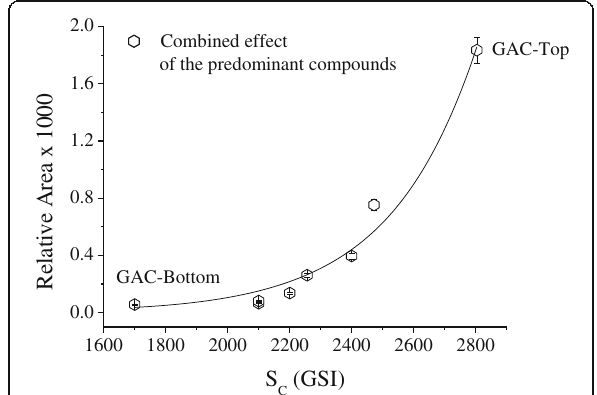
Fig. 15 Relation between Sc and relative area under the TD-GC/MS